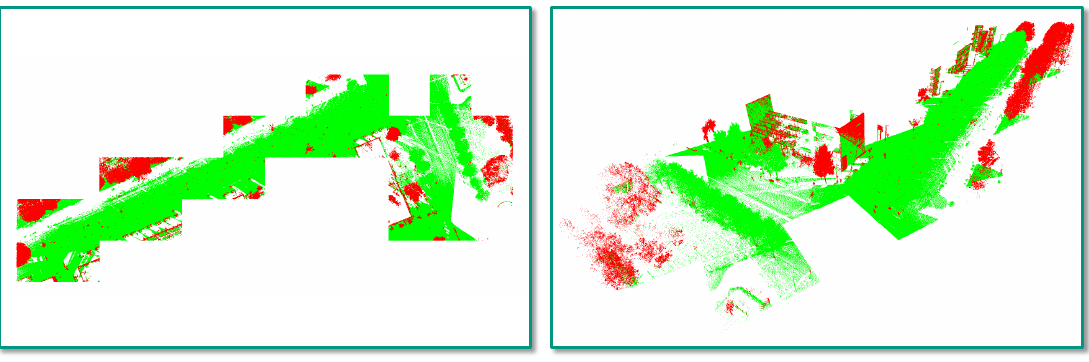
Figure 12. Visualization of the failure cases in the form of misclassifications that particularly occur for trees and building facades ( left : nadir view; right : side view): those 3D points that are correctly classified with respect to the provided labeling are colored in green, whereas those 3D points that are not correctly classified with respect to the provided labeling are colored in red (the classification result corresponds to an overall accuracy of 90.07% and a kappa value of 71.54%; cf. Figure